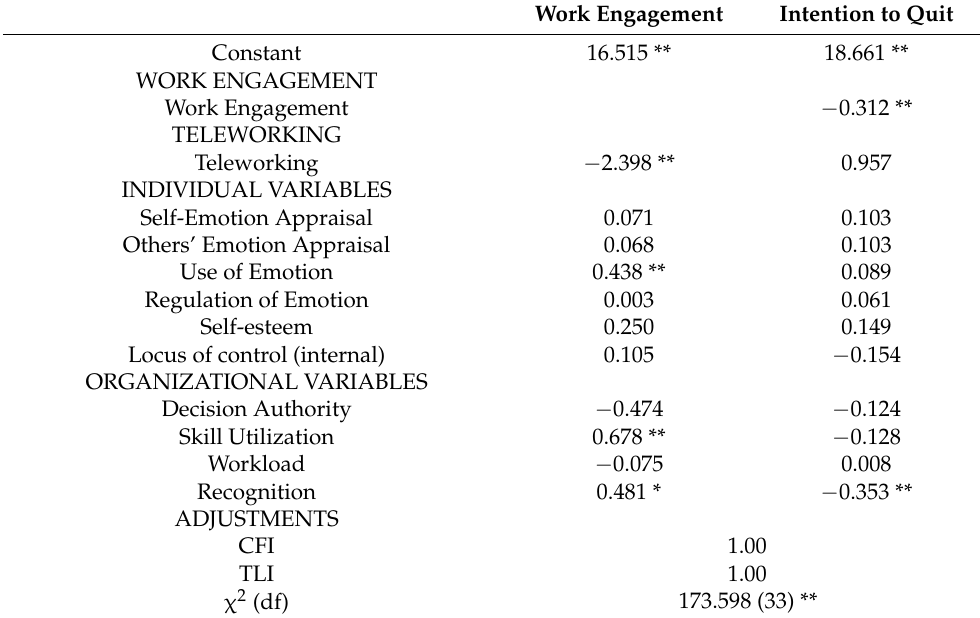
Table 2. Direct Effects of Teleworking, Individual and Organizational Variables on Work Engagement and Intention to Quit.